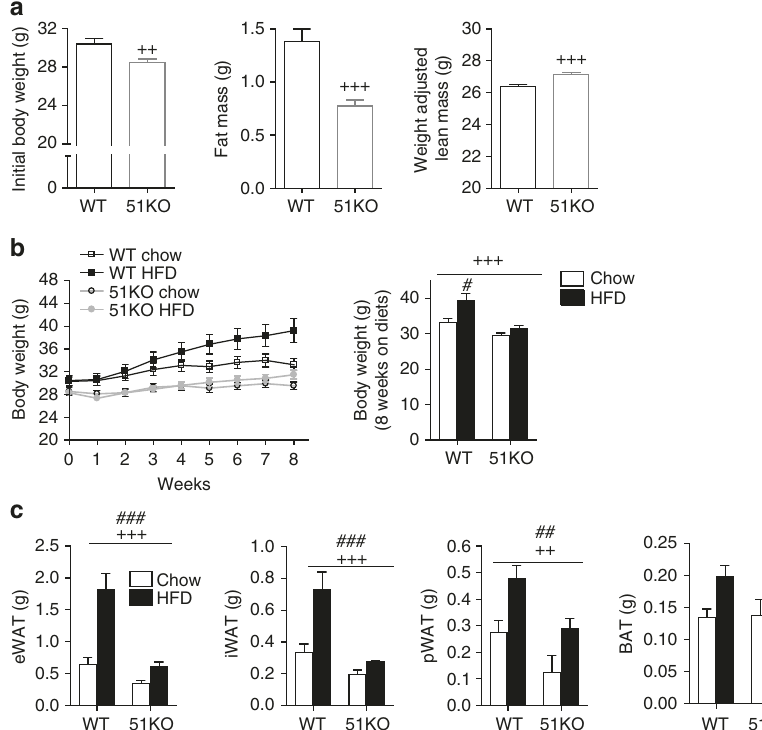
Fig. 1 Genetic ablation of FKBP51 prevents HFD-induced weight gain. a 51KO mice ( n = 16) presented lowered body weight, decreased fat mass, and increased lean mass compared to WT littermates ( n = 18) at the onset of the dietary feeding period. b 51KO mice weighed signi fi cantly less than WT mice throughout the 8-week dietary treatment and at the experimental end ( n = 9 WT-Chow, n = 9 WT-HFD, n = 9 51KO-Chow, n = 7 51KO-HFD). Whereas WT mice were susceptible to HFD-induced weight gain, 51KO mice were not as interpreted from weight progression and fi nal body weight (following 8 weeks on respective diets). c After 8 weeks on the dietary treatment, 51KO mice presented decreased fat pad weights for epididymal (e), inguinal (i), and perirenal (p) white adipose tissues (WAT) compared to WT counterparts whereas presented no change in brown adipose tissue (BAT) mass. HFD exposure signi fi cantly increased fat pad mass, regardless of genotype. Lean mass was adjusted for body weight and is expressed for a 30-g mouse. Data are represented as mean ± SEM. + P < 0.05, ++ P < 0.01, +++ P < 0.001; # P < 0.05, ## P < 0.01, ### P < 0.001, two-tailed t test for a , Repeated measures ANOVA and two-way ANOVA for b , two-way ANOVA for c ; + signi fi cant genotype effect; # signi fi cant diet